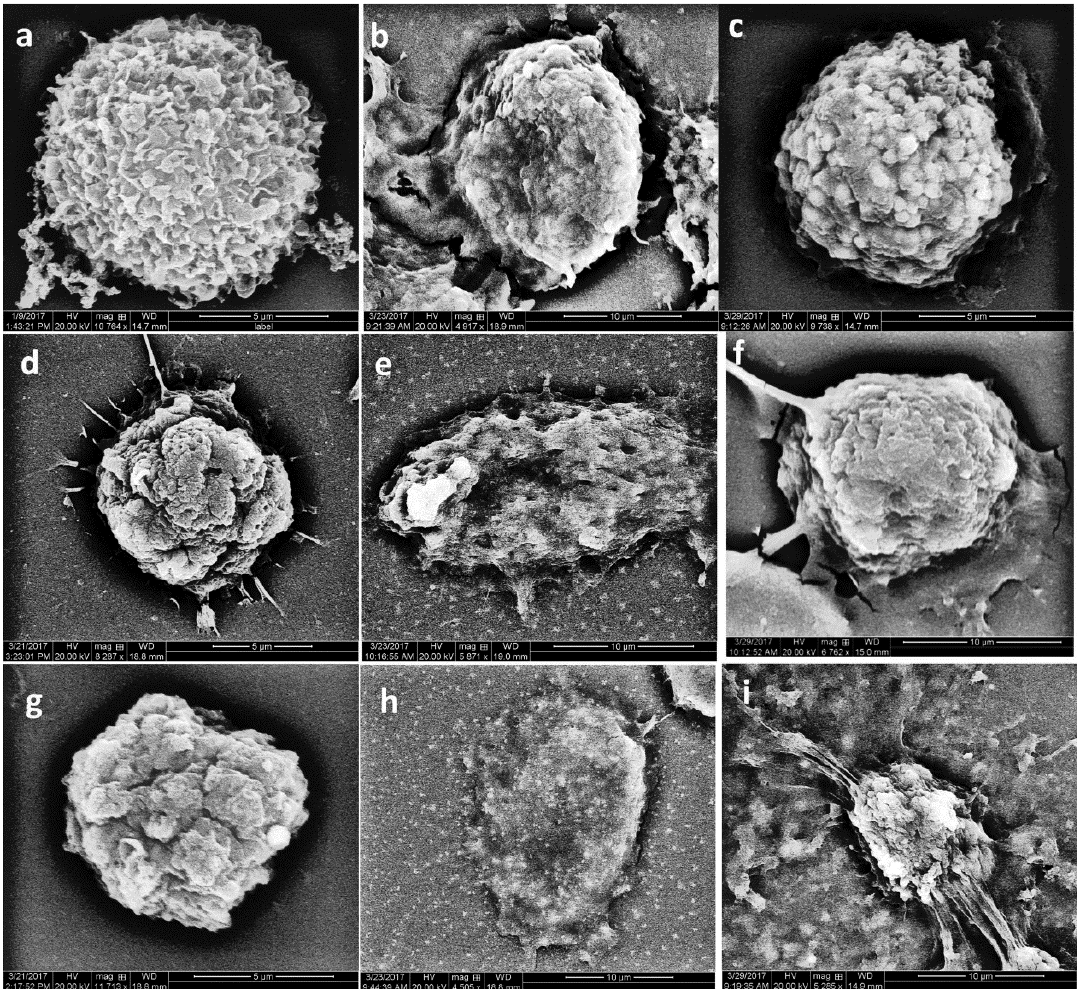
Figure 2. Scanning electron photomicrographs of control untreated mesenchymal stem cells ( a – c ), and those treated with Endosequence Root Repair Material (ERRM) ( d – f ) or ProRoot-mineral trioxide aggregate (MTA) extract ( g – i ) incubated for one, three, and seven days, respectively.